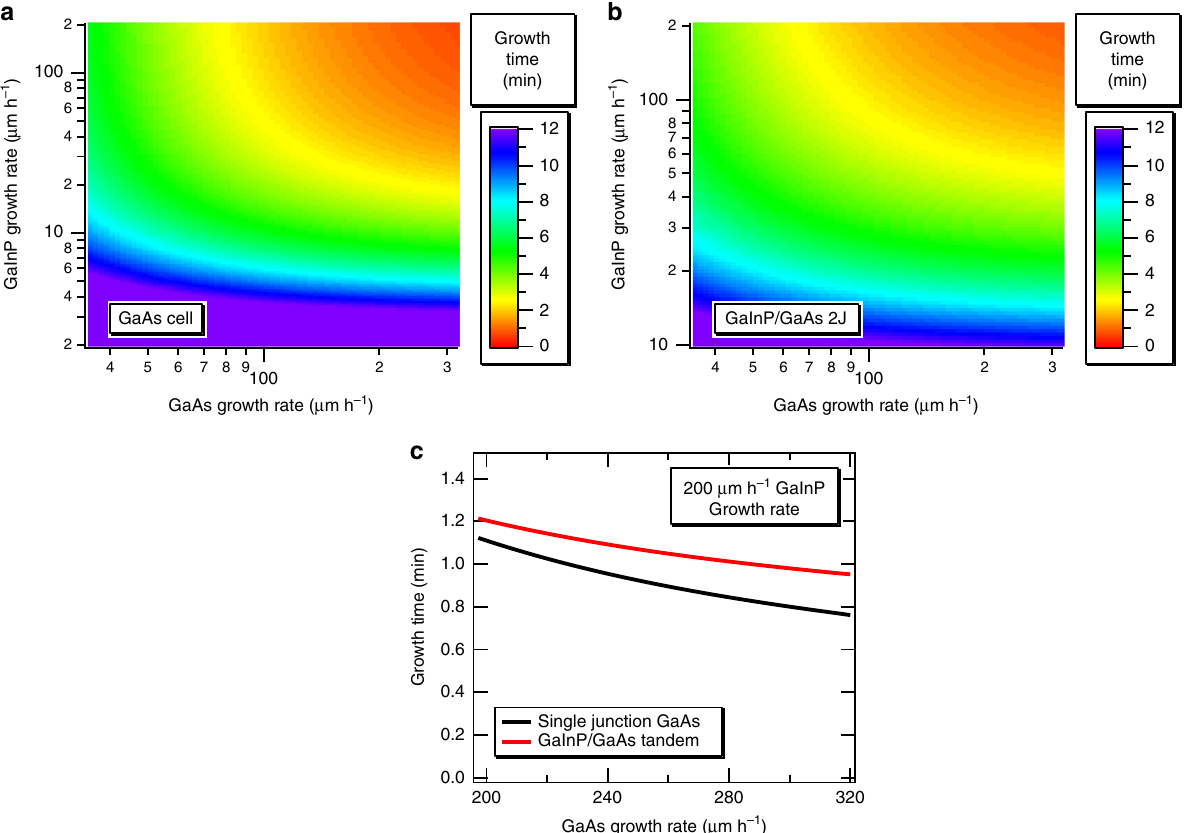
Fig. 6 Impact of high growth rate on device throughput by a future optimized in-line HVPE reactor. a Total growth time for the single-junction GaAs solar cell structure shown in Fig. 1b as a function of the GaAs and GaInP growth rates, total growth time for a GaInP/GaAs two-junction solar cell structure ( b ), and slices through the data of Fig. 6b, c showing continued and signi fi cant growth time decreases at very high rates ( c